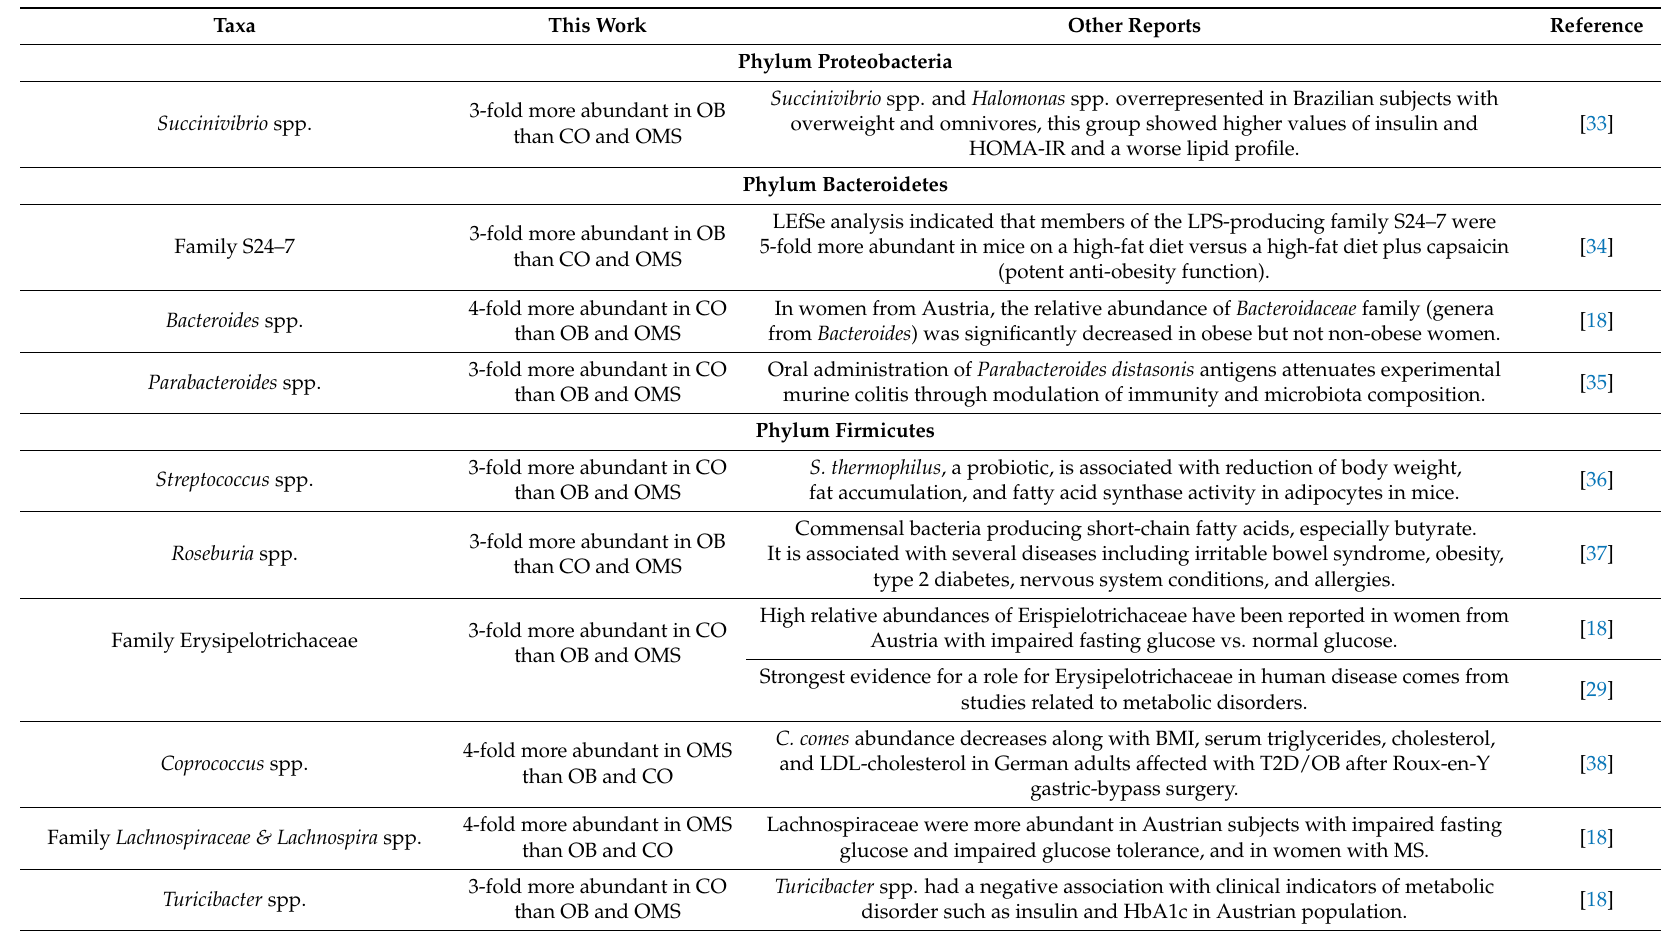
Table 2. Gut bacteria with significant abundance change among study